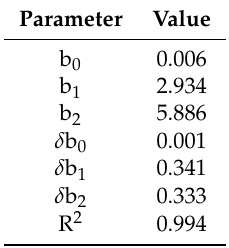
Table 2. Fit parameters for multivariate regression of data points using Ga I 287.4-nm line